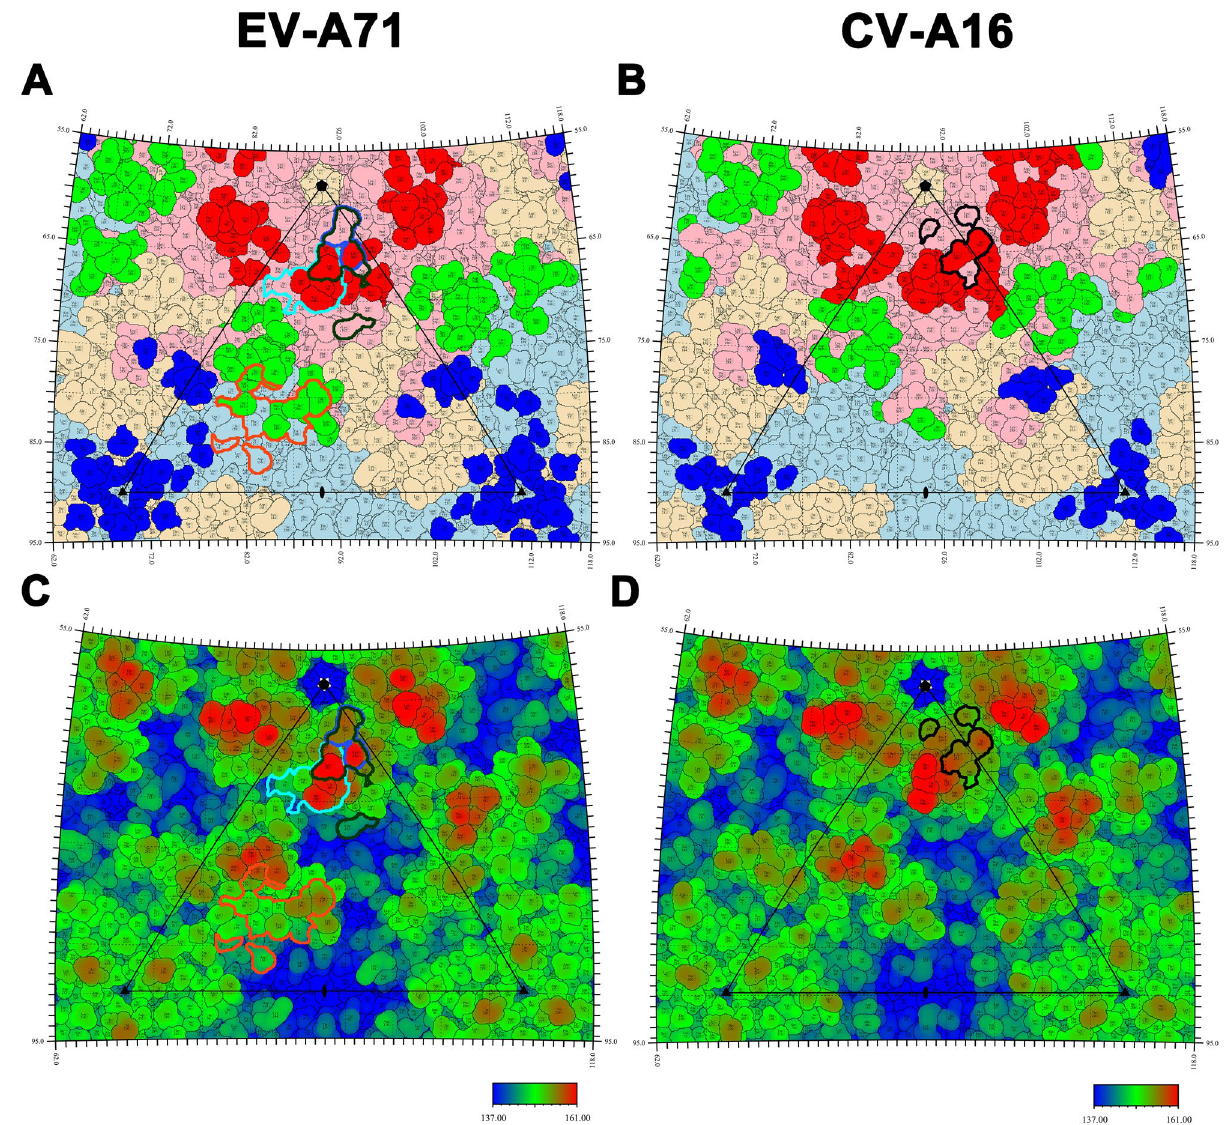
Figure 4. Receptor footprints on the capsid surface of EV-A71 and CV-A16. The icosahedral subunit and color role are the same as Fig. 3. The footprints of different receptors are indicated by colorful solid lines. ( A , C ) The footprints of four receptors SCARB2, PSGL-1, HS and Anx2 on EV-A71 are circled in dark orange, blue, dark green, cyan, respectively. ( B,D ) The footprint of HS on CV-A16 is circled by